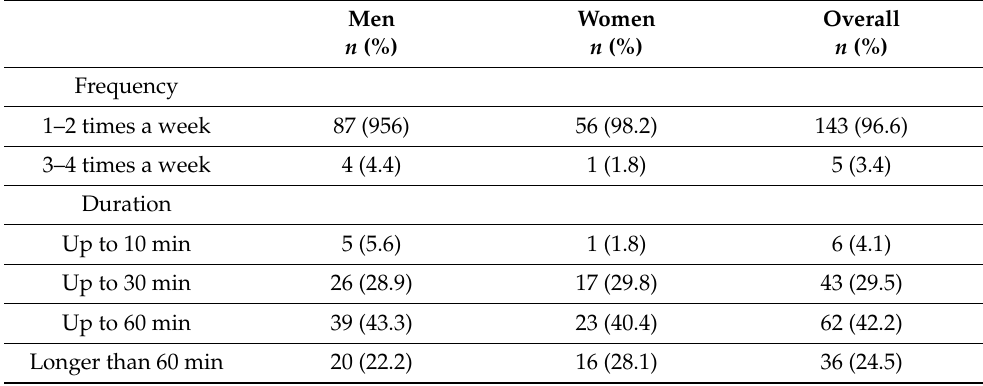
Table 8. Frequency and duration of sauna